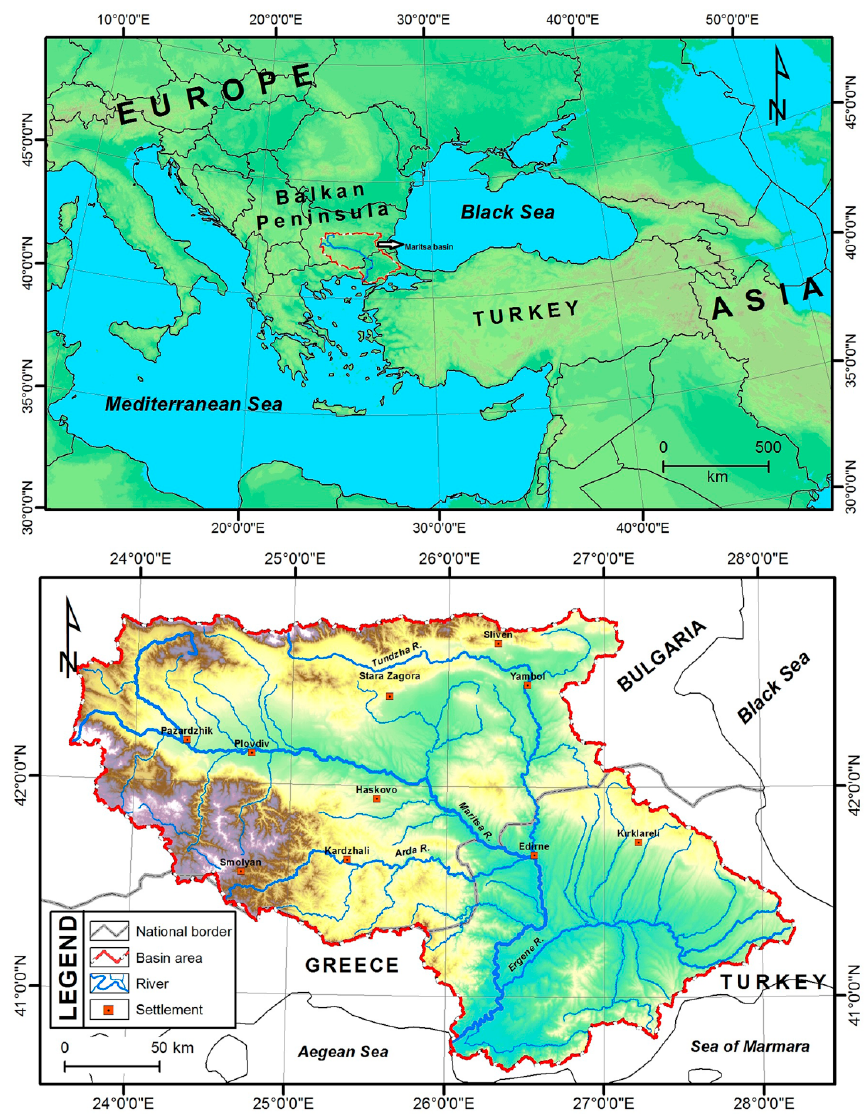
Figure 1. Location of the Maritsa Basin and its network.